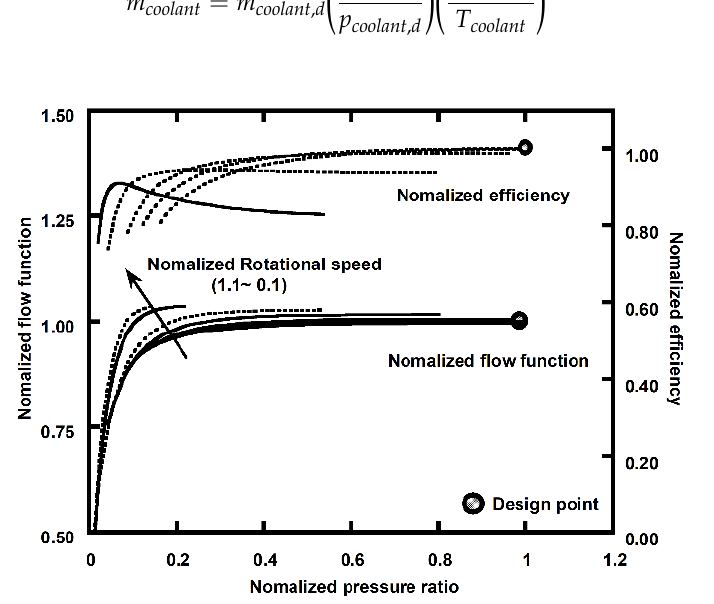
Figure 4. Compressor performance map.